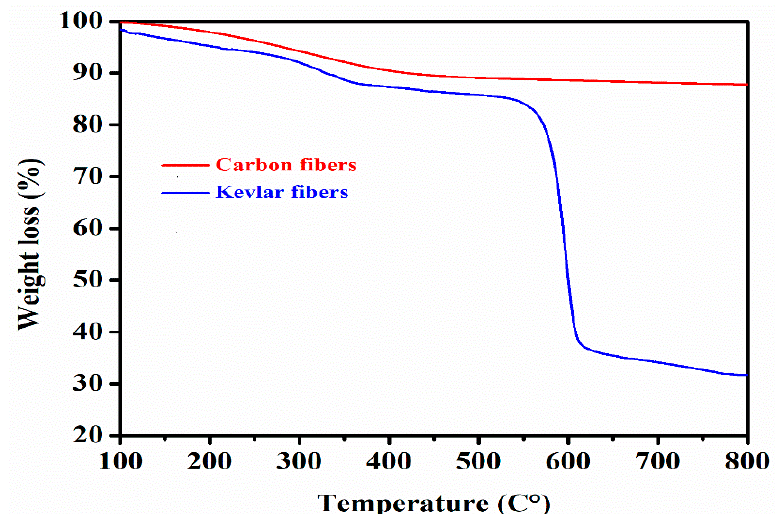
Figure 5. Thermal stability of the carbon fibers and Kevlar fibers.